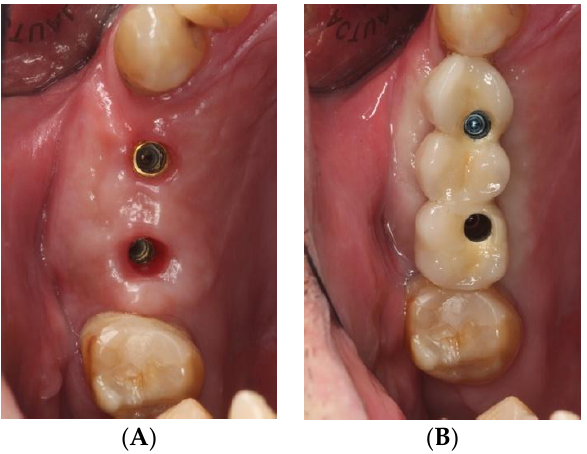
Figure 5. ( A ) two tissue level implants PRAMA RF in position 1.4 and 1.6, ( B ) fixed partial prosthesis (3 pieces) on 2 tissue level implants PRAMA RF.